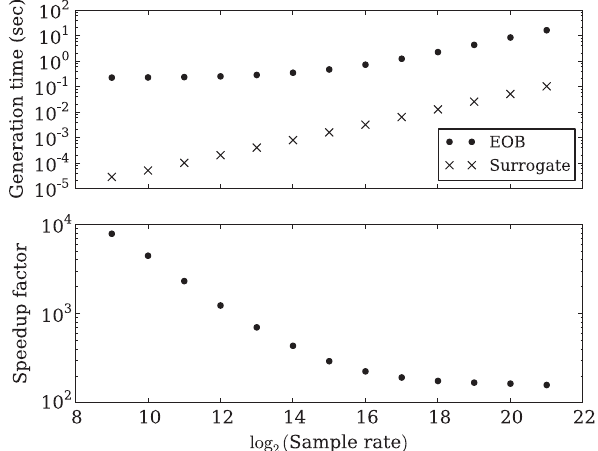
FIG. 10. Top panel: Average time to generate a single fiducial EOB waveform from a standard EOB code (circles) and through evaluation of its surrogate (crosses). Here, we show results for the nominal example when using polynomial least squares fits for the amplitudes and phases. Bottom panel: The speedup, defined as the ratio of waveform generation times for EOB-LAL code to the surrogate